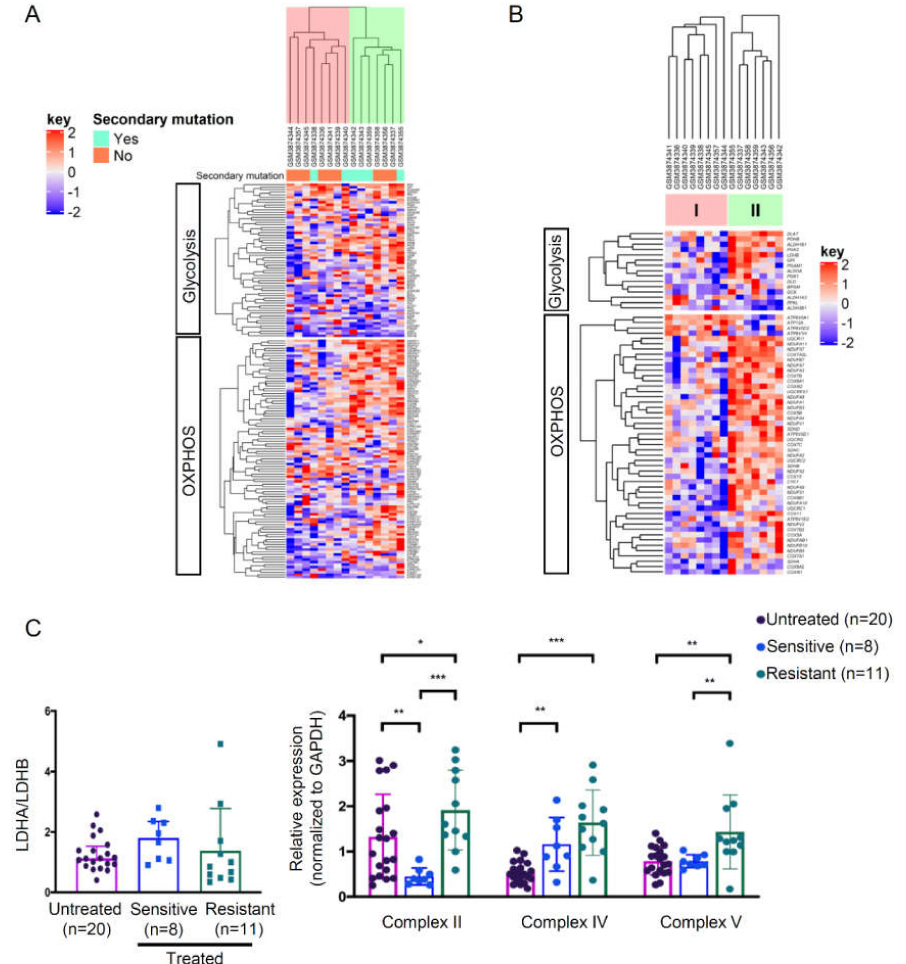
Figure 7. Expressions of OXPHOS and glycolysis genes in the GIST tumor samples. ( A , B )